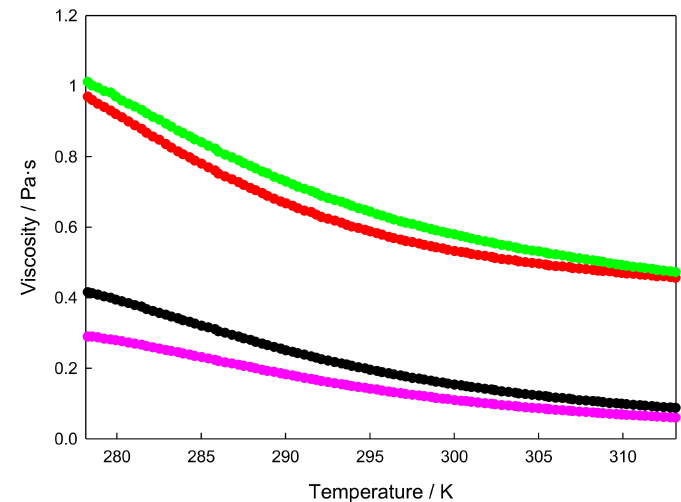
Figure 9. Viscosity at 10 s − 1 shear rate versus temperature for xGnP / [C 2 C 1 py][C 4 F 9 SO 3 ] at mass concentrations:( — ) 0 wt%; ( — ) 1 wt%; ( — ) 5 wt%; and ( — ) 10